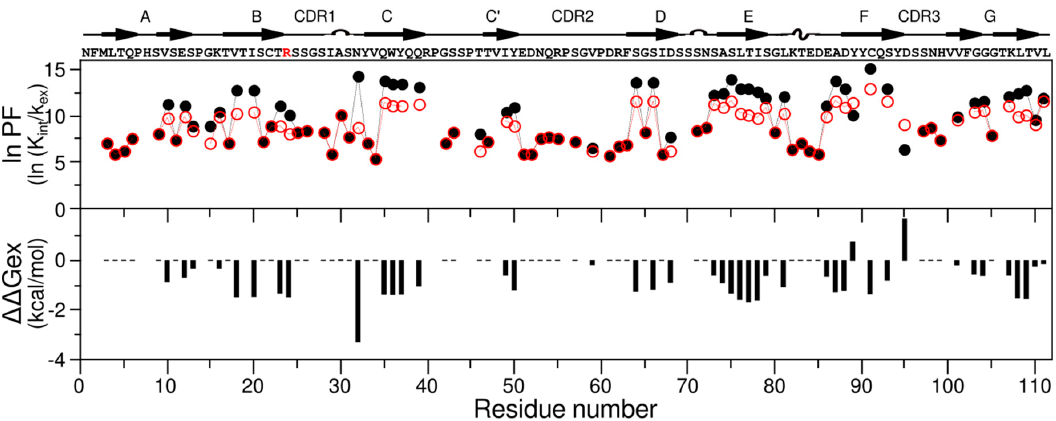
Figure 5. Stabilities as reported for the H/D experiments of 6aJL2 (black) and 6aJL2-R24G (red). Top panel: Plot of protection factors as a function of residue number. Bottom panel: Difference in stabilities due to the mutation R24G. Protein sequence and secondary structure are indicated above the top panel. The protein sequence and secondary structure elements are indicated above the top panel. The mutation site is shown in red.